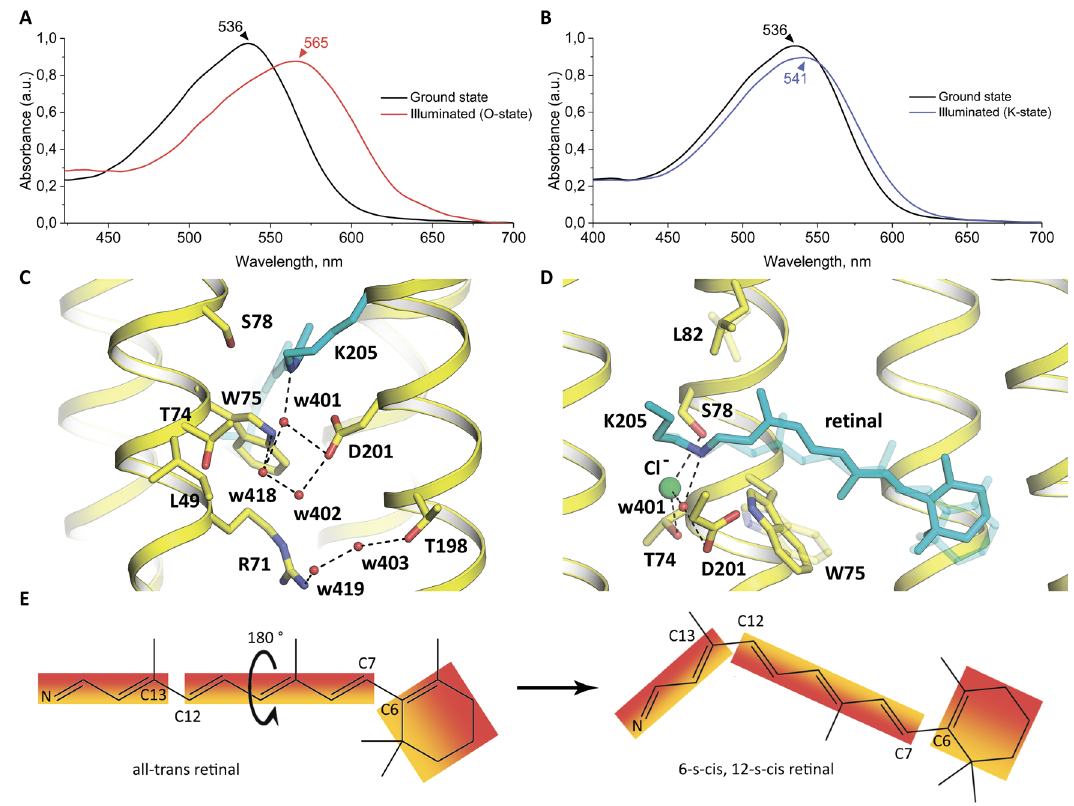
Fig. 4 | Structures and spectra of active states. A Cryotrapping of the O state of the Sy HR photocycle in crystals. Visible light absorption spectra of the red crystals of Sy HR before (black line) and after (red line) illumination by the 532-nm laser for 2secondsat293K. B CryotrappingoftheKstateofthe Sy HRphotocycleincrystals. Visible light absorption spectra of the red crystals of Sy HR before (black line) and after (blue line) illumination by the 532-nm laser for 1minute at 100K. C Structure